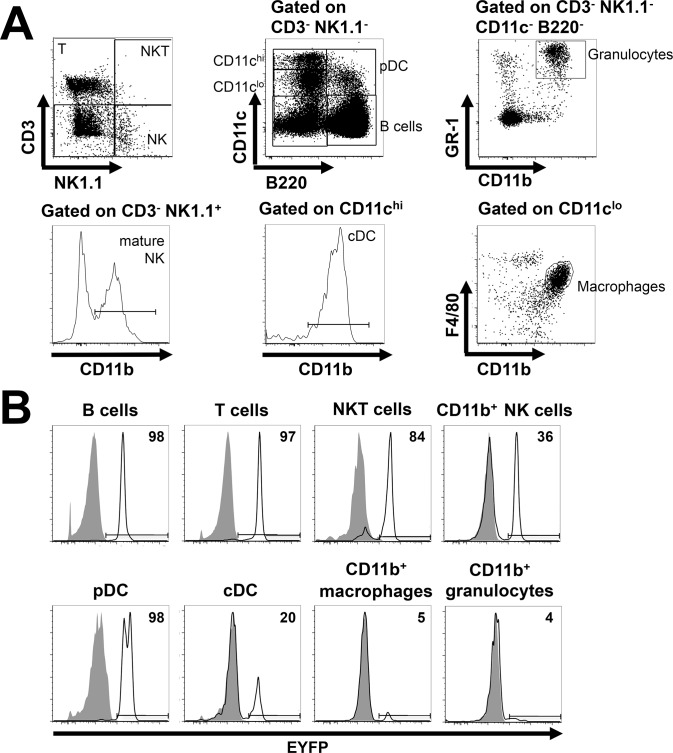

hCD2-iCre activity in mature leukocytes.
(A) Gating strategy. Splenocytes were stained with the indicated AB and analyzed by FACS, gating on CD3+NK1.1- T cells, CD3-NK1.1+CD11b+ mature NK cells, CD3+NK1.1+ NKT cells, CD3- NK1.1-CD11c-CD11b+B220-Gr-1hi granulocytes, CD3-NK1.1-CD11cloB220+ pDC, CD3-NK1.1-CD11chi CD11b+B220- cDC, CD3-NK1.1-B220+ B cells and CD3-NK1.1-CD11cloF4/80+CD11b+ macrophages. (B) EYFP expression in the indicated mature leukocyte populations from hCD2-iCre
+/-
R26-stop-EYFP
+/- (open histograms) and R26-stop-EYFP
+/- mice (shaded histograms). Numbers depict % EYFP+ cells in the hCD2-iCre
+/-
R26-stop-EYFP
+/- mice. Representative of three independent experiments (n = 3 for each genotype).